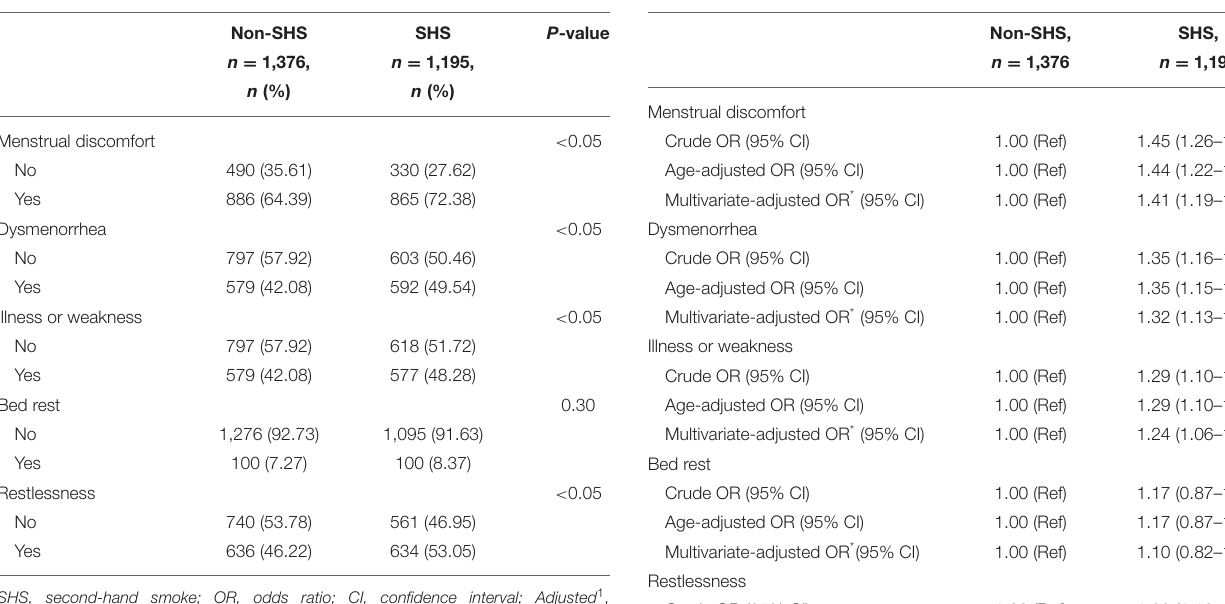
TABLE 2 | Association between SHS and menstrual discomfort symptoms ( n = 2,571).